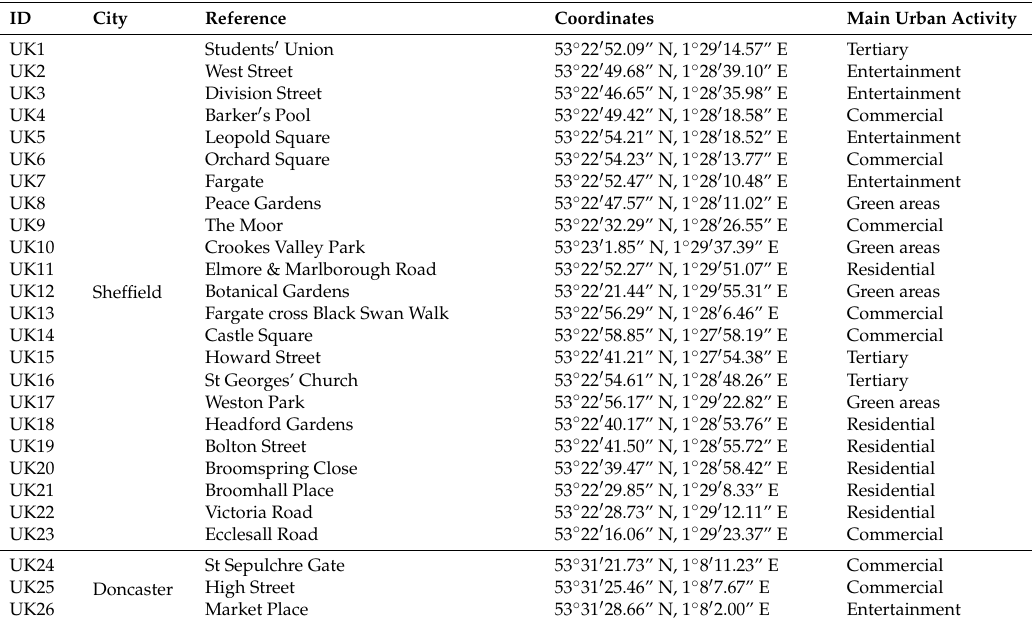
Figure 4. Scheme representing the procedure for audio ‐ visual data collection. Table 1. Locations selected for data collection and main urban activity taking place there.